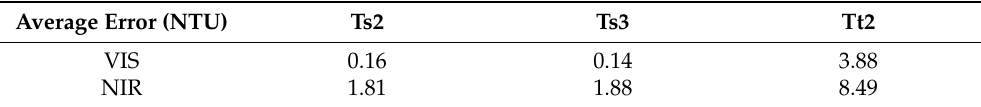
Table 8. Statistics of average error percentages for continuing monitoring of tap water turbidity verified by different lighting sources.